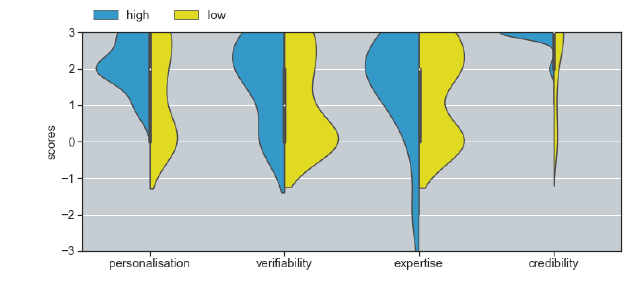
Figure 3. Motivational design techniques regarding trustworthi- ness &